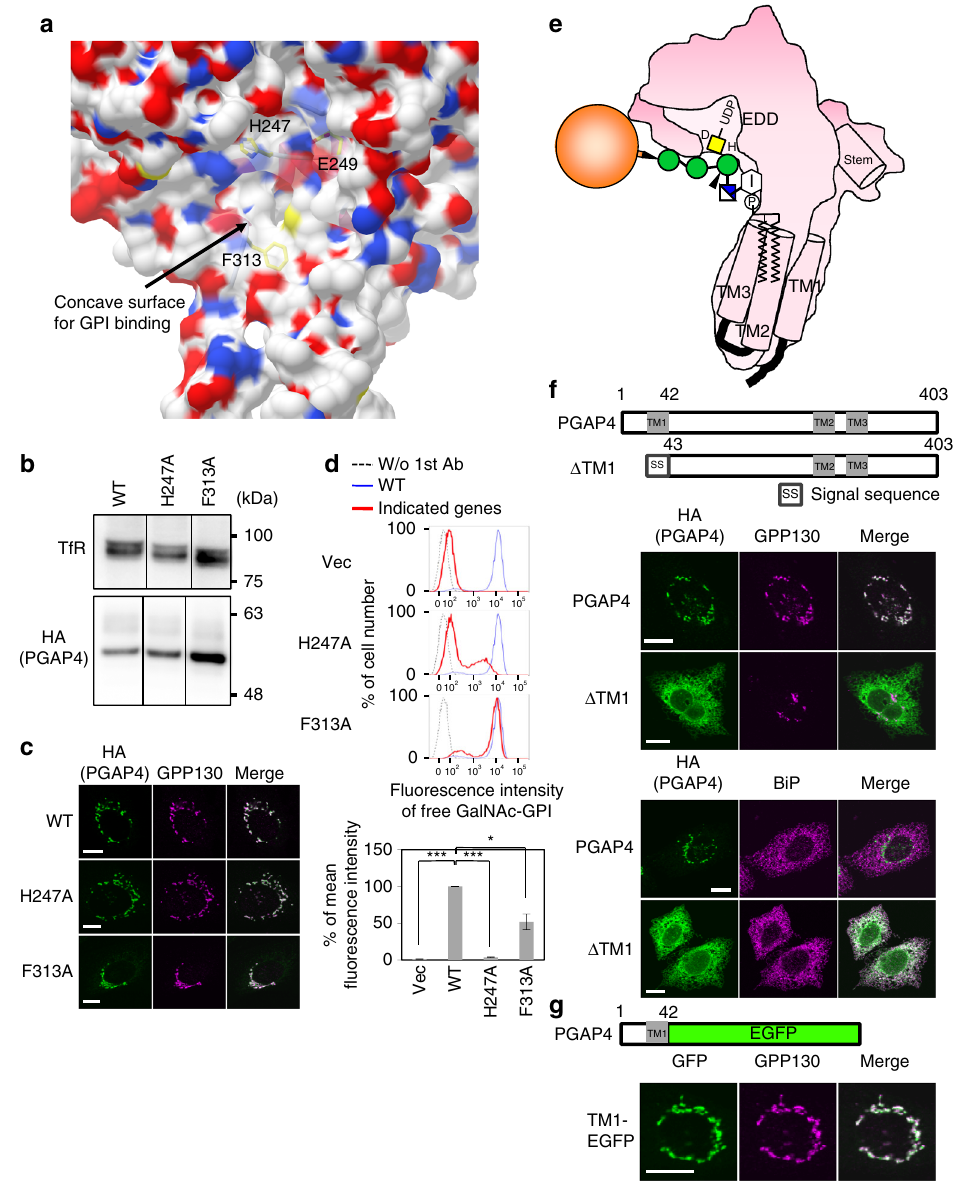
Fig. 6 Functional analysis of the concave surface in the juxtamembrane region and the fi rst TMD. a Enlarged view of the concaving surface near the catalytic cavity. H247, E249, and F313 are exposed on the surface and located between UDP-GalNAc-binding site and TMDs. b – d Functional analysis of H247A and F313A mutant PGAP4. For western blotting ( b ) and immuno fl uorescence imaging ( c ), pME-hPGAP4-3HA with WT or mutant sequences was transiently transfected into 3BT5-PGAP4-KO cells. b TfR, loading control. c , d Representative data from two independent experiments. c GPP130, the Golgi marker. Scale bars: 10 µ m. d Flow cytometry. 3BT5-PGAP4-KO cells were transiently transfected with pTK-hPGAP4-3HA. Cells were stained with T5 mAb. Dotted lines, background staining; blue lines, PGAP4 WT; red lines, PGAP4 mutants. Quantitative data of mean fl uorescence intensity ( ± SD) from three